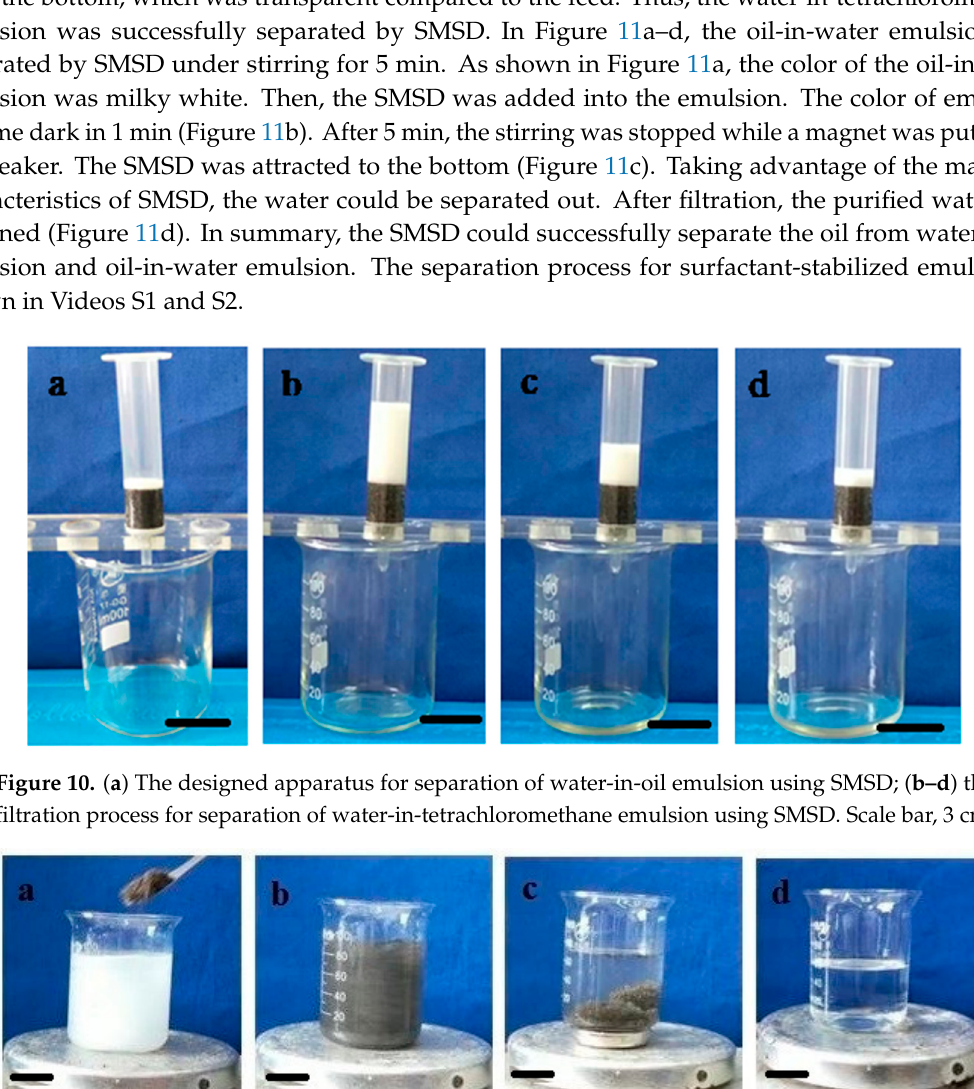
Figure 11. The separation of oil-in-water emulsion using SMSD: ( a ) adding of SMSD; ( b ) after 1 min; ( c ) after 5 min; ( d ) the separated water. Scale bar, 2 cm.